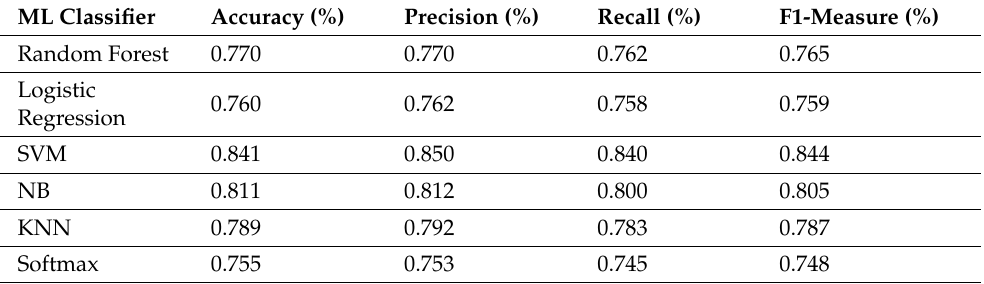
Table 5. Roman Urdu CNN-LSTM performance with various ML classifiers using RUSA dataset.